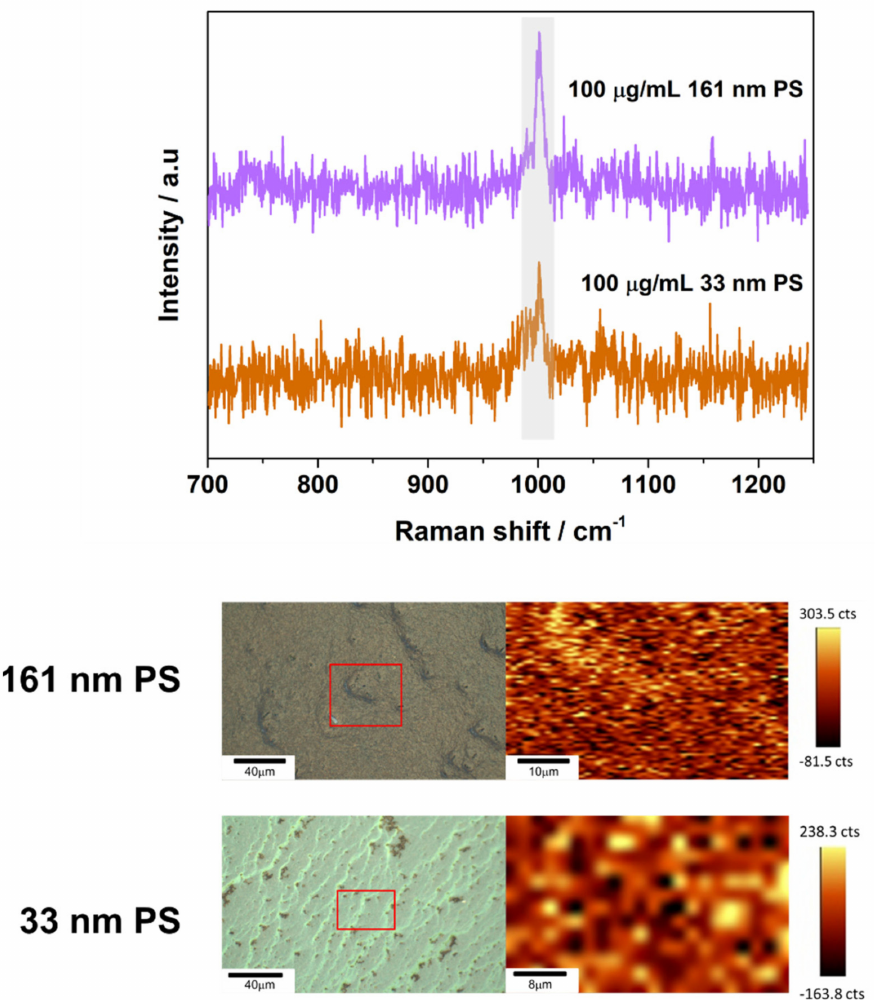
Figure 4. Representative SERS spectra obtained through automated mapping for 100 µ g/mL samples of 161 nm PS particles on 46 nm AuNP substrates and samples of 100 µ g/mL of 33 nm PS nanoparti- cles on 46 nm AuNP substrates. Laser power, scan speeds, and number of averaged accumulations for the samples can be viewed in Table A1. Spectrum obtained are shown above images of the intensity maps for the PS peak at 1002 cm − 1 and the regions of interest (ROIs) the measurement was obtained from. Spectra come from regions of high intensity for the peak at 1002 cm − 1